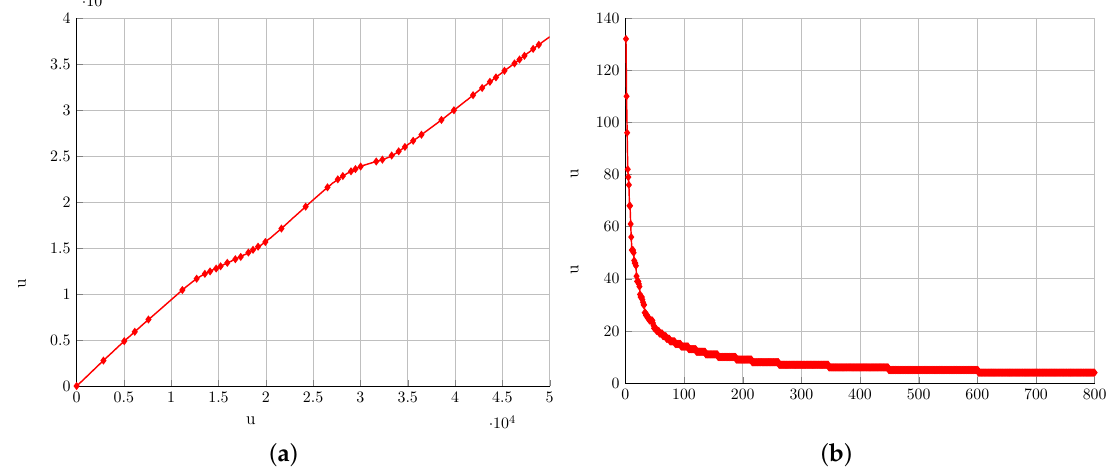
Figure 8. Illustration for the Lena benchmark. ( a ) Number of regions versus number of iterations; ( b ) Number of occurrences for a region (sorted in descending order, clipped at the 800th